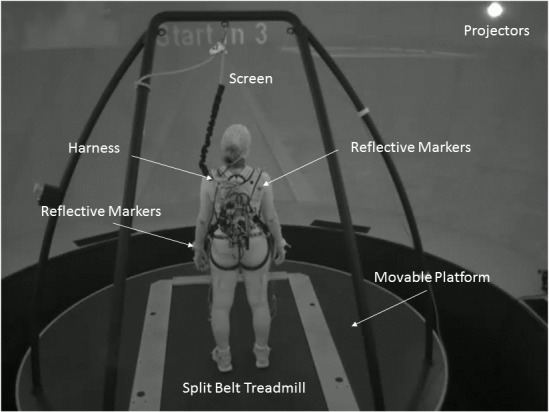
Experimental setup.Participants walked on a treadmill in self-paced mode. The treadmill is embedded in a moveable platform with six degrees of freedom (three translations and three rotations). They were exposed to unexpected platform (medio-lateral) or treadmill (anterior-posterior) perturbations in a virtual reality environment. Vicon motion capture cameras were used to calculate walking parameters of step length and step width based on marker data from the feet. A small backpack was used to carry a wireless amplifier connected to biosensors (e.g., electroencephalography, electromyography), data from which are not reported here.